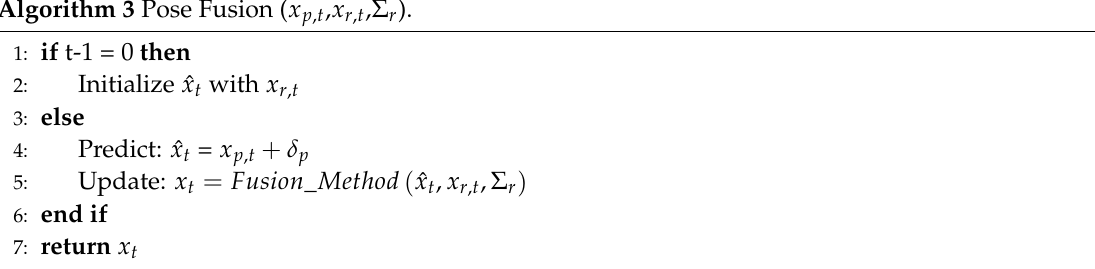
Algorithm 3 Pose Fusion ( x p , t , x r , t , Σ r ).